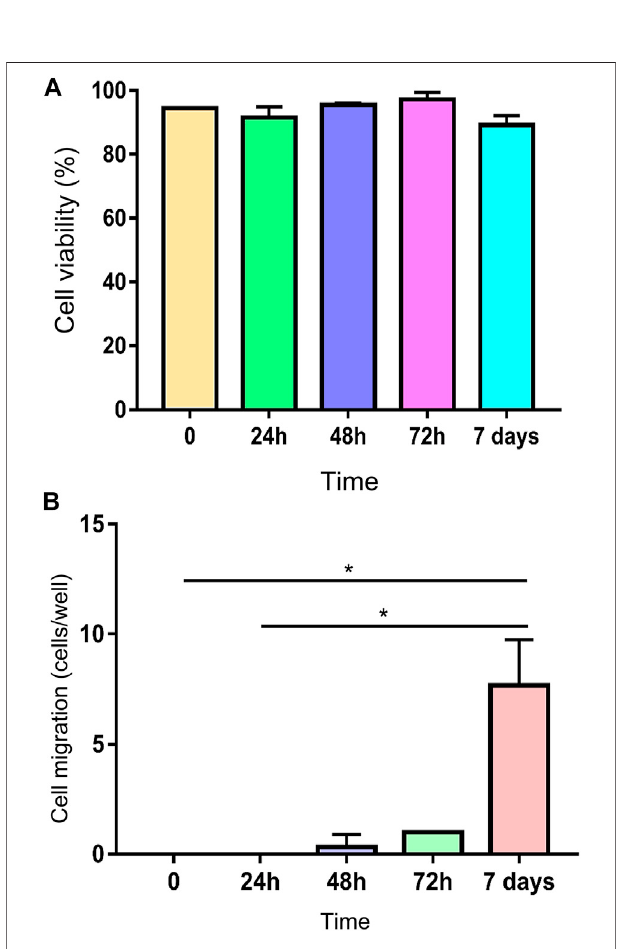
FIGURE 7 | (A) Viability of encapsulated MSCs at 0, 24, 48, 72 h and 7 days, showing a maintenance of high viability through time. (B) Cell migration from the scaffold to the plastic bottom of the wells (* means p (cid:2) 0.0434).